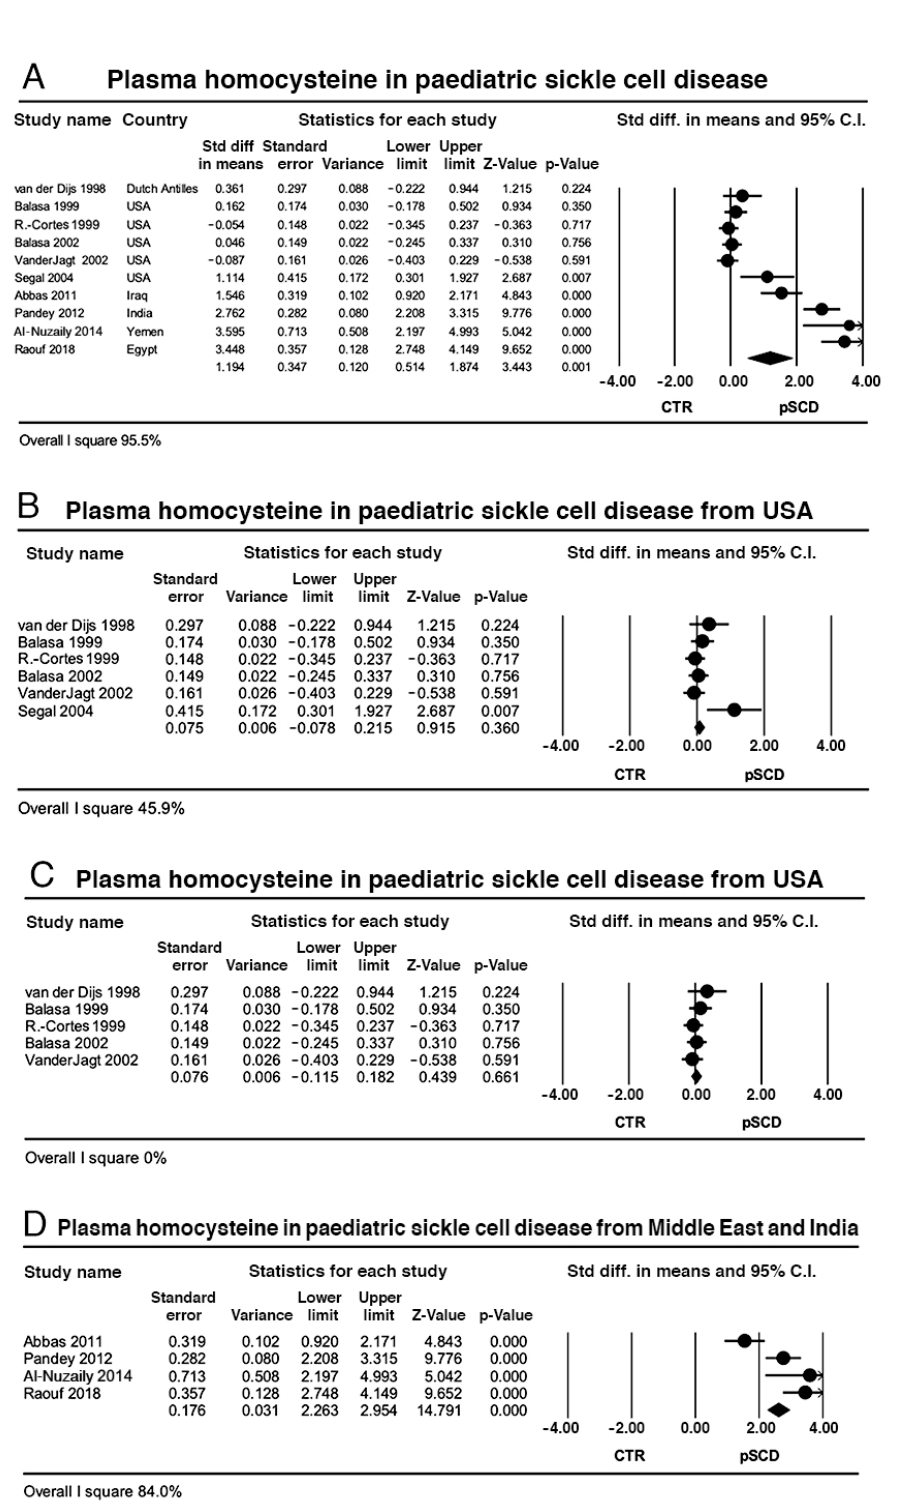
Figure 3. ( A ) Effect size of studies comparing plasma homocysteine in control and in paediatric sickle cell disease; ( B ) subgroup analysis on one study from the Dutch Antilles and the five studies from USA; ( C ) subgroup analysis as in B after removal of the outlier study from USA; ( D ) subgroup analysis on three studies from Arab countries and one from India.